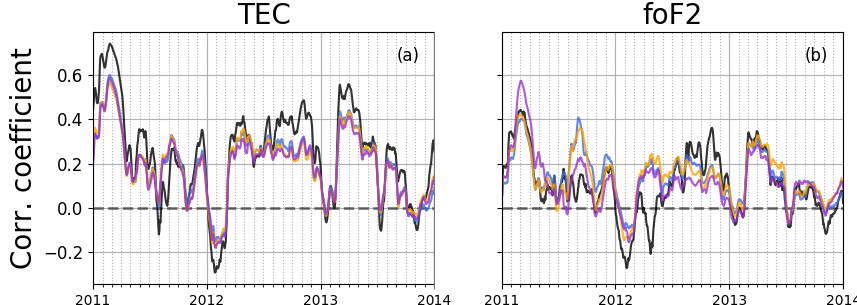
Figure 7. The plots show the correlation coefficients of the ionospheric parameters TEC (a) and fo F2 (b) with integrated EVE fluxes (6 to 105nm) for Tromsø (black), Pr˚uhonice (blue), Rome (orange), and Athens (purple). All parameters were analyzed at an hourly resolution using a time window of 90d and a step size of 1h.